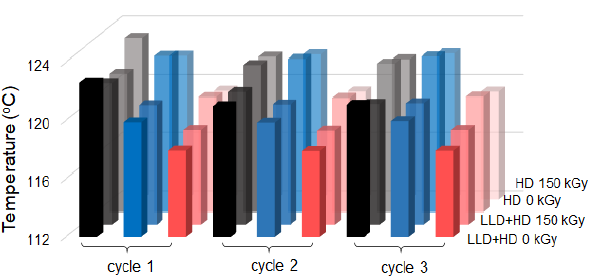
Figure 15. Correlation of T (cid:48) max ( (cid:4) ) from cooling ρ -T curves with T c ( (cid:4) ) and T offset ( (cid:4) ) from cooling DSC curves. The color intensities decrease from front to back, in order to facilitate the comparison of the parameters.